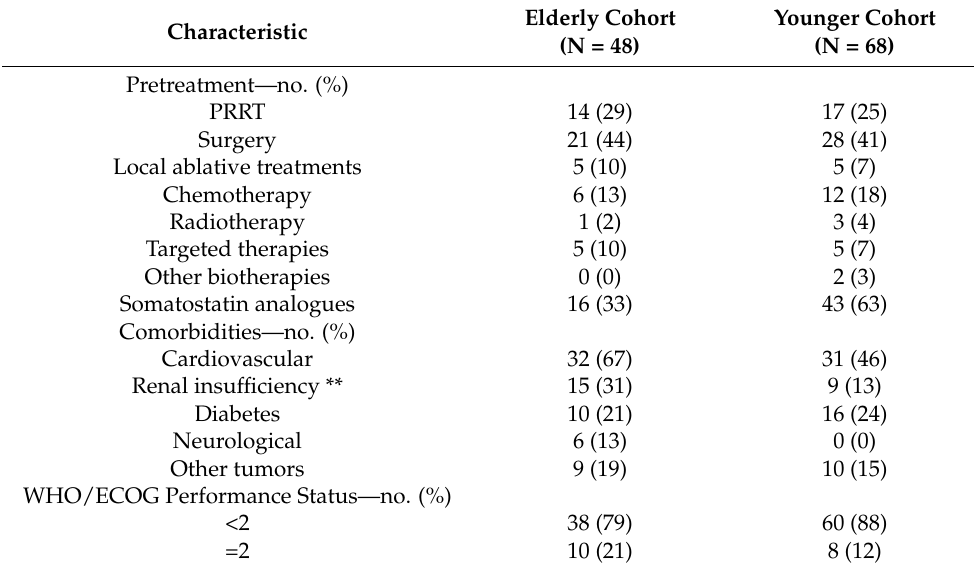
Table 2. Baseline patient demographics and clinical characteristics